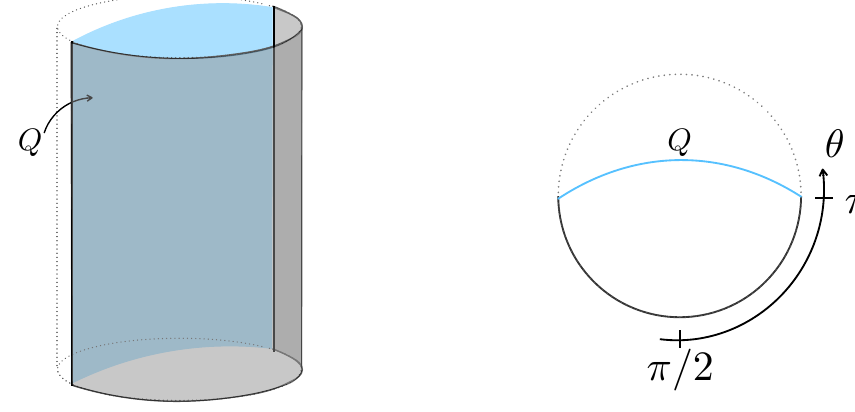
Figure 5 . Global AdS 3 with an end-of-the-world brane (left) and its time slice (right).